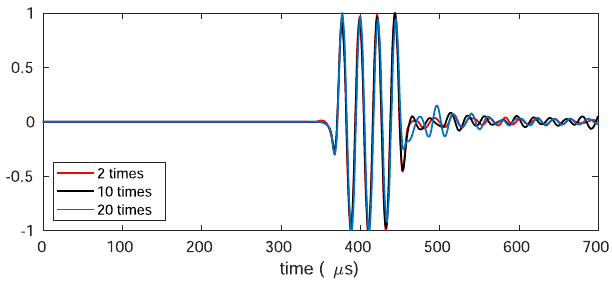
Figure A.2. Comparison of the signals for a slice with 3 different resolutions: 0.22 mm (red), 1.1 mm (black), 2.2 mm